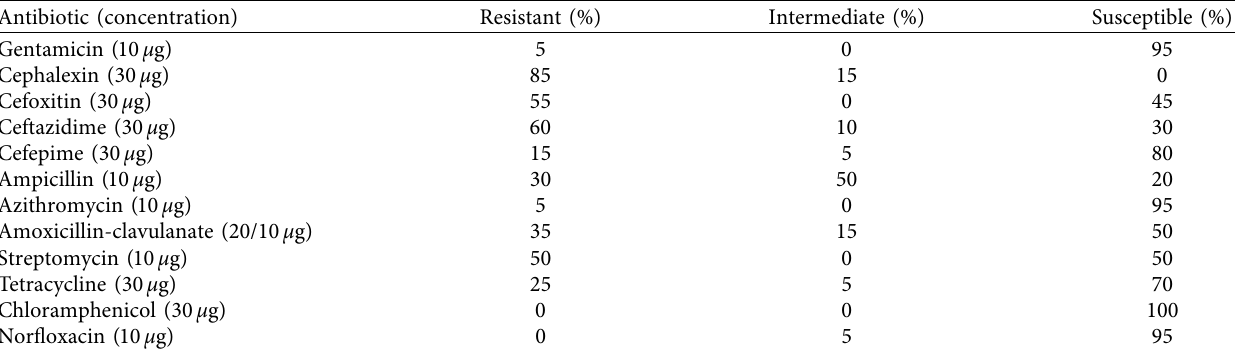
Table 6: Antibiogram of E. coli ( n � 20) isolated from milk and milk products sold in various outlets in Juja Sub-County, Kenya. Antibiotic